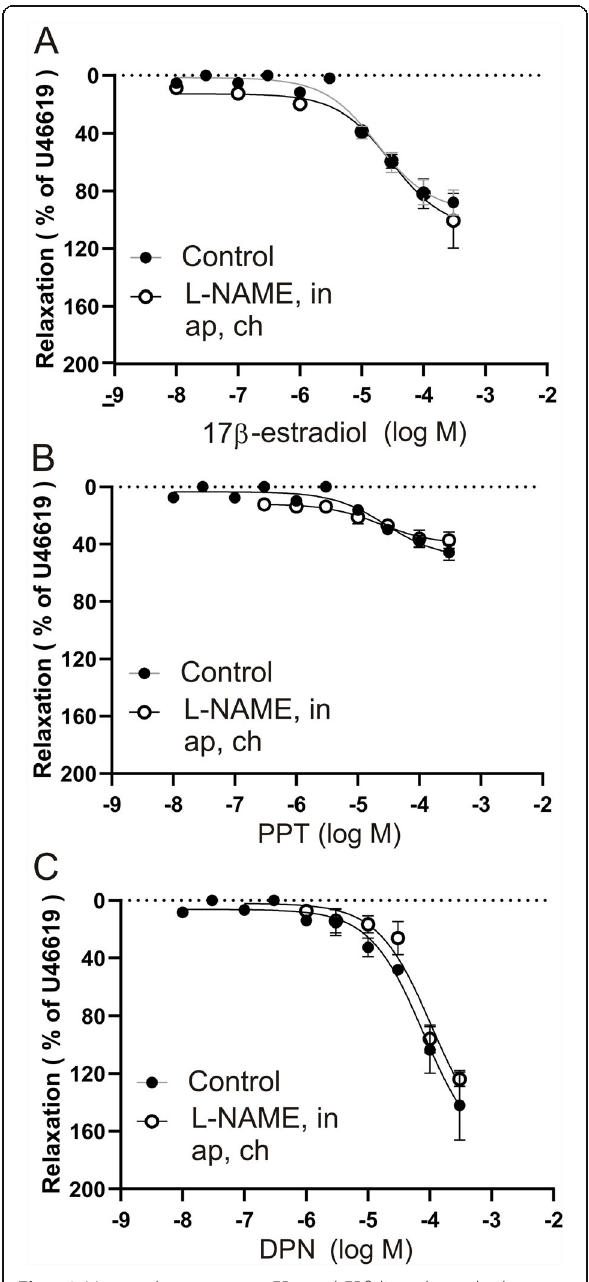
Fig. 13 Myograph response to ER α and ER β ligands on the human female dural vessel. Isolated segments of human female dural artery in the wire myograph. The data are shown as dilation from a preconstriction of U46619. To inhibit the endothelium L-NAME, indomethacin, apamin and charybdotoxin, where added. Cumulative concentration-response curves are shown for 17 β -estrogen ( a ), PPT ( b ) or DPN ( c ). Data points represent means ± SEM. Significance was determined by two-way ANOVA, n = 6. * p < 0.05, ** p < 0.005, *** p <